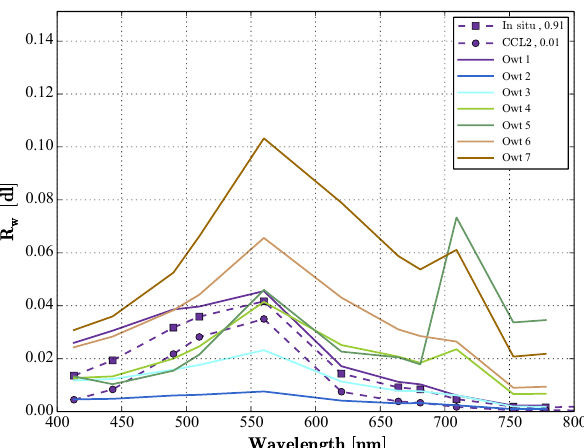
Figure 4. OWT end-member water-leaving reflectance spectra and a OWT 2 retrieval example for an in situ and MERIS CCL2 re- flectance pair from Lake Zurich, 15 August 2007. Respective class membership scores are indicated in the legend.